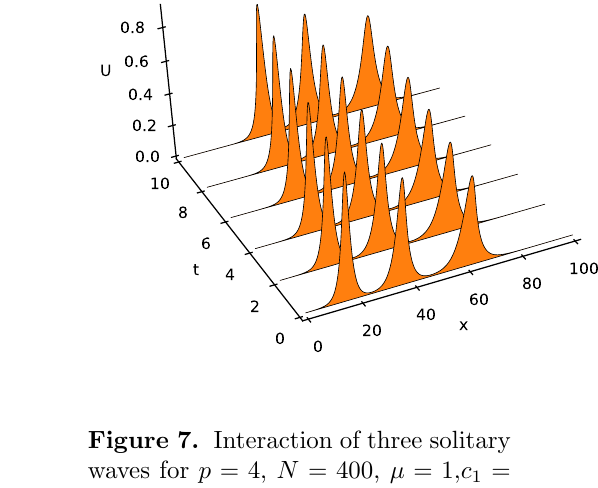
Figure 7. Interaction of three solitary waves for p = 4, N = 400, µ = 1 ,c 1 = 0 . 6, c 2 = 0 . 3, c 3 = 0 . 15, x 1 = 15, x 2 = 35 and x 3 = 60 at t = 0 , 2 , 4 , 6 , 8 , 10.